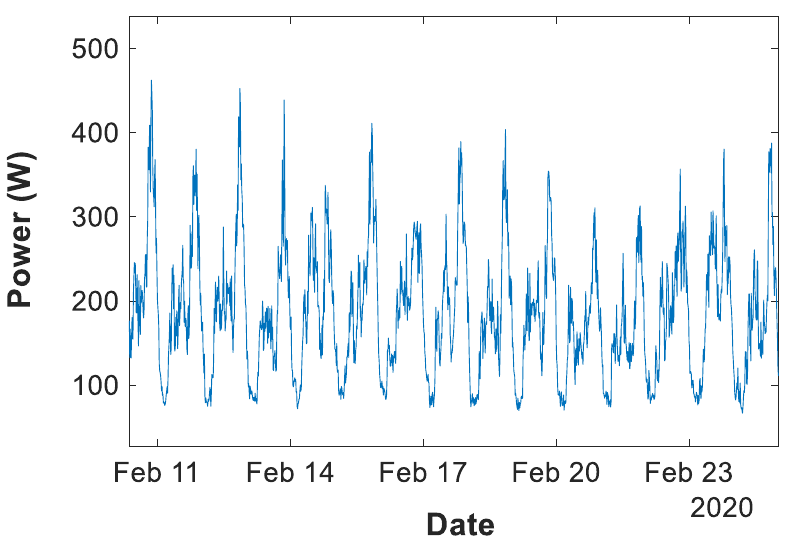
̂ , of Cluster AAAA-BA during 11 – 25 February 2020. Figure 11. The power profile estimator, (cid:98) Y k , of Cluster AAAA-BA during 11–25 February 2020. 𝑘